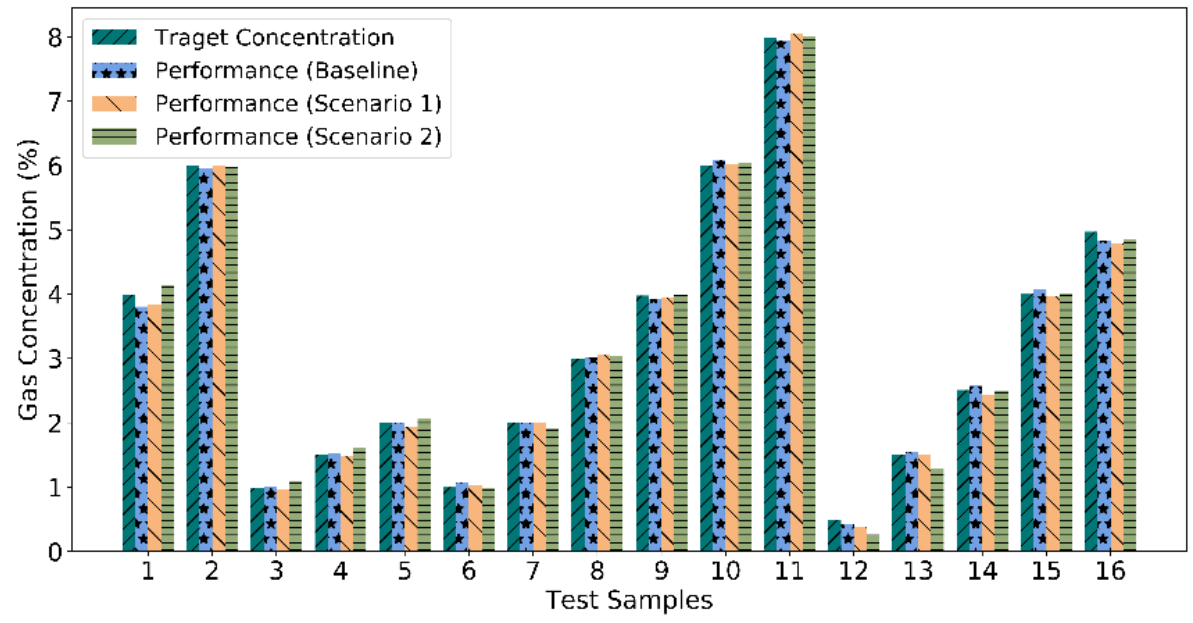
Figure 5. Quantification performance in terms of actual vs. predicted percent concentration of the considered gases for baseline, scenario 1, and scenario 2 experiments.